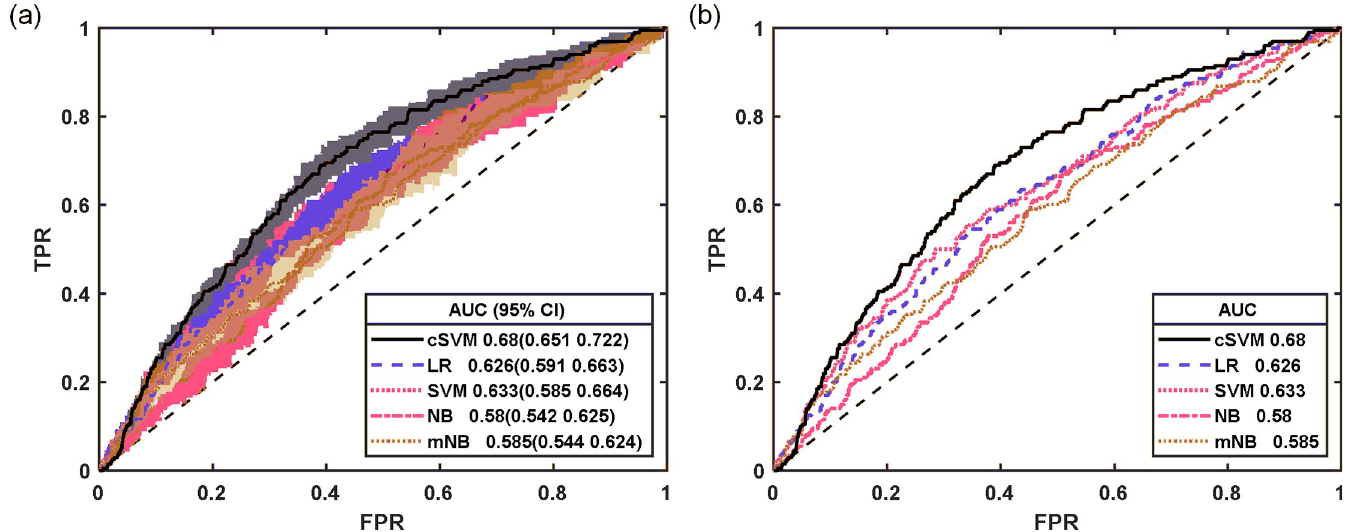
Fig 3. AUC of different classifiers.